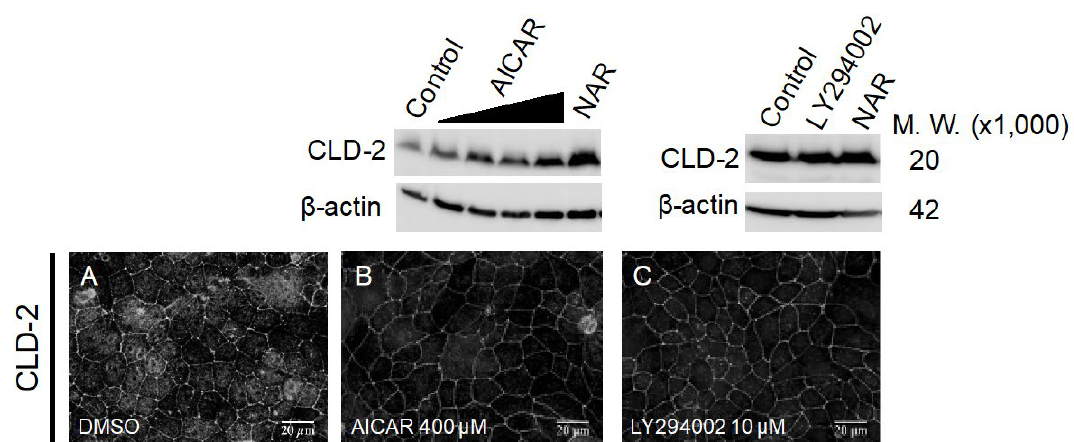
Figure 7. Effects of AICAR and LY294002 on CLD-2 level and localization in MDCK II cells. Top panel: Western blotting analysis of CLD-2 level in cell lysates from control and 100 μM NAR-treated, 20, 100, 200 and 400 μM AICAR-treated, and 10 μM LY294002-treated MDCK II cells. Bottom panel: Immunofluorescence staining of CLD-2 images are displayed. Cells were treated with AICAR at a concentration of 400 μM for 48 h ( B ) or LY294002 at a concentration of 10 μM for 3 h ( C ), and DMSO is used for control ( A ). Scale bar = 20 μM. Brightness is modified to 130%. In Supplementary Figure S9, we show raw materials for membrane. M.W.: molecular weight, CLD: claudin, MDCK: Madin–